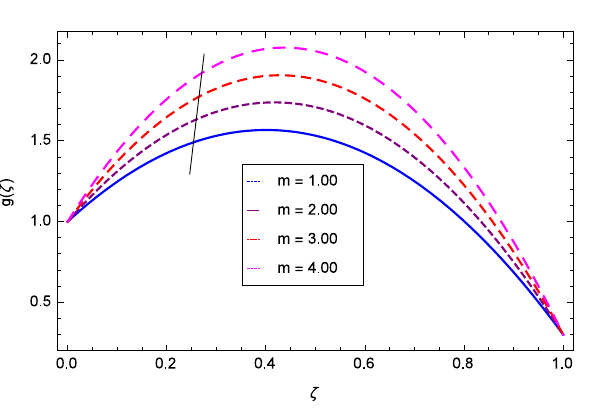
Figure 8. Analysis through Hall parameter m and tangential velocity g ( ζ